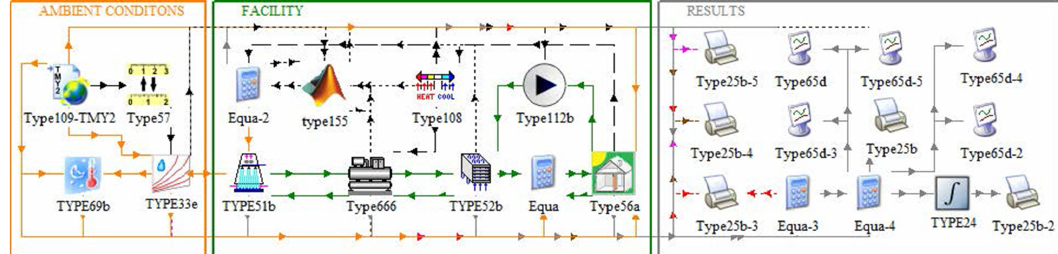
Figure 1. Schematic arrangement of the TRNSYS